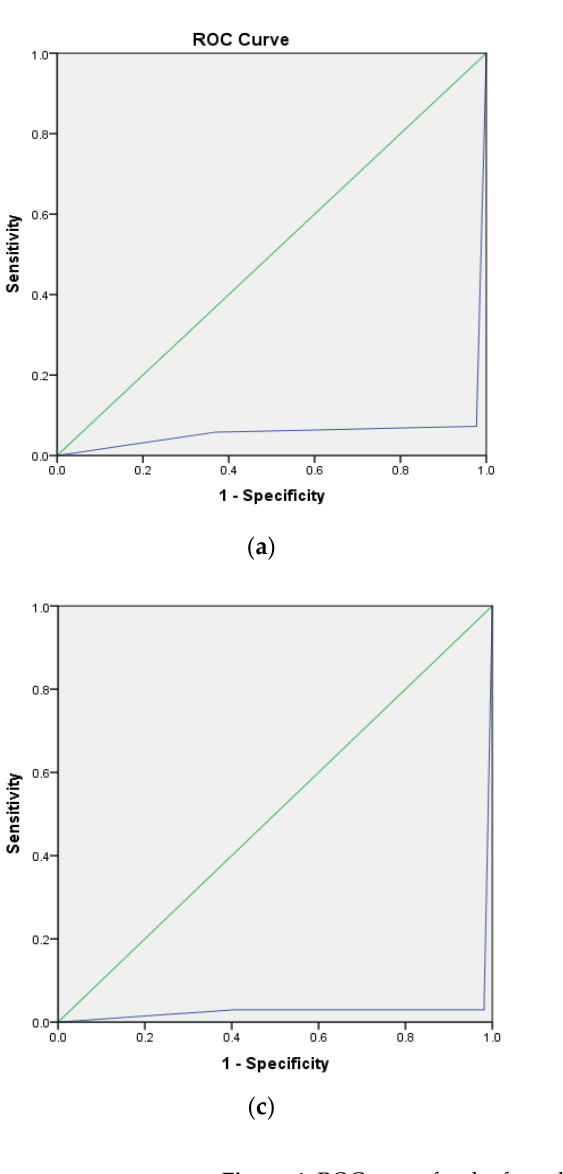
Figure 6. ROC curve for the four classifiers. Predicted has at least one tie between the positive actual state group and the negative actual state group. ( a ) MLP, AUC-ROC: 0.966. ( b ) RF, AUC-ROC: 0.997. ( c ) SVM, AUC-ROC: 0.966. ( d ) Bagging, AUC-ROC: